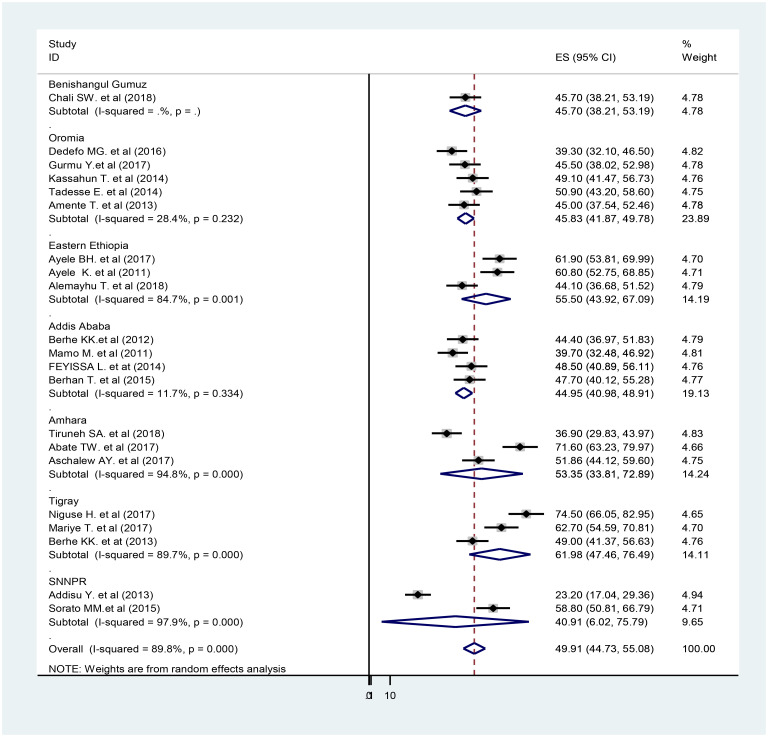
A subgroup analysis of the forest plot showing the pooled proportion of non-adherence to self-care practice among DM in Ethiopia, 2011–2019.